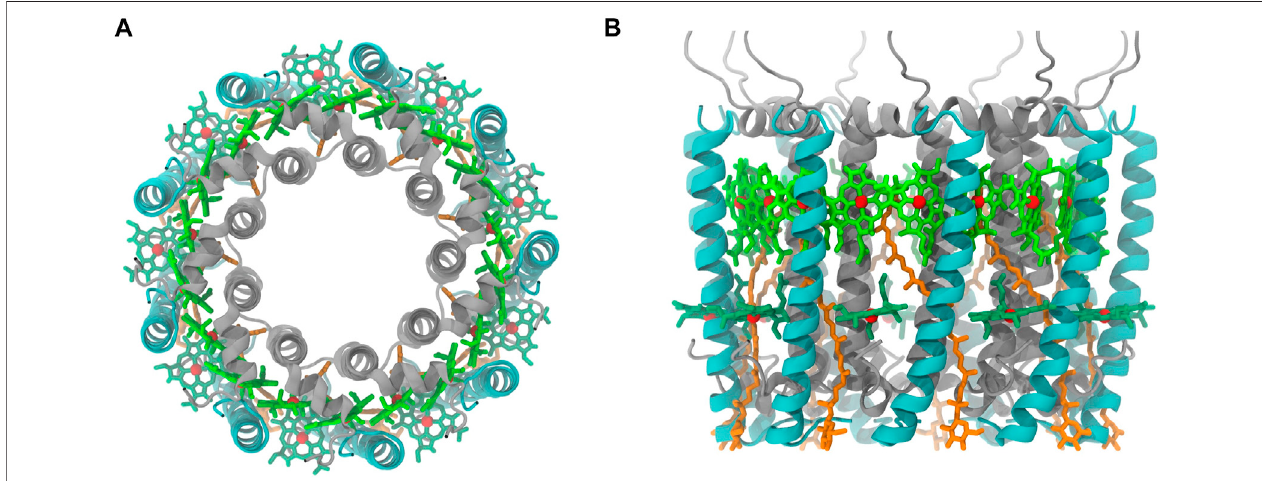
FIGURE1| Purplebacteria LH2complex( (A) ,topview (B) ,sideview). α and β polypeptidehelicesarecolorinsilverand cyan,respectively.Pigmentmoleculesare colored in dark green (B800), bright green (B850), and orange (RG1). The phytol portion in BChl was not displayed.